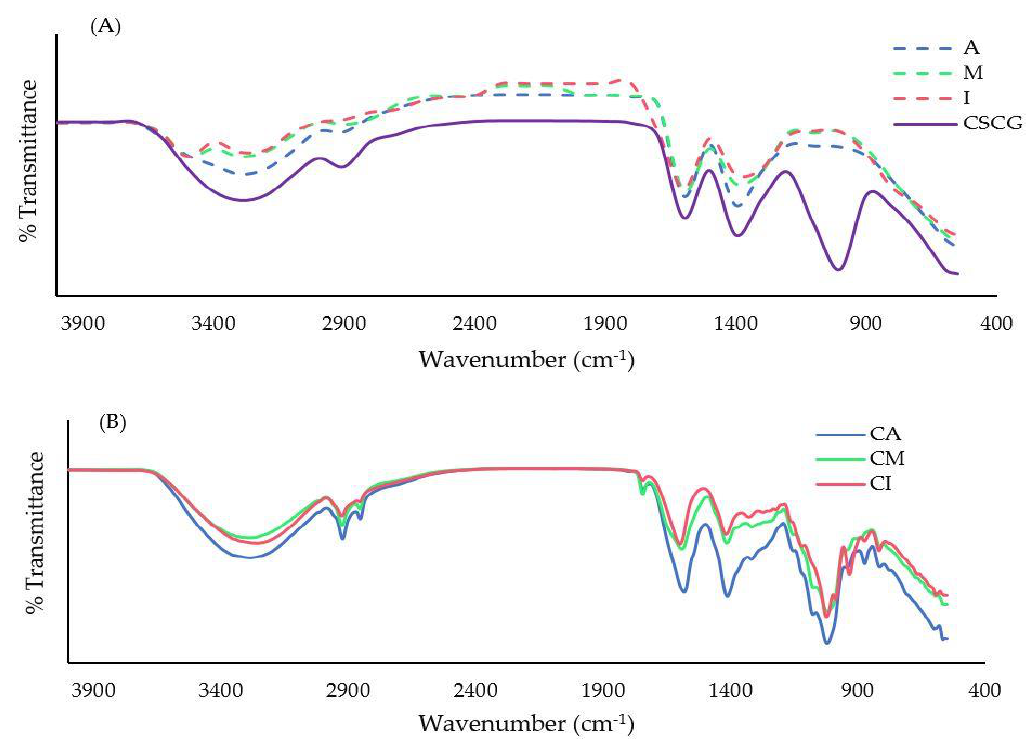
Figure 1. The FT − IR spectrum of antioxidant crude extract from CSCG (CSCG), A, M, and I ( A ), CA, CM, and CI ( B ).